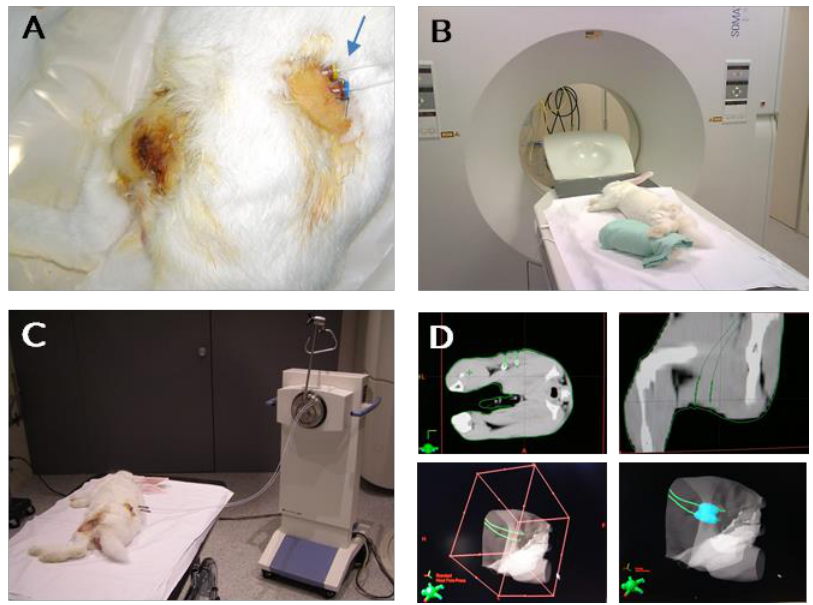
Figure 1. Images of rabbits undergoing brachytherapy procedure. ( A ) Catheters implantation in left posterior rabbit ’ s limb as brachytherapy source applicator (blue arrow). ( B ) Imaging assurance of correct positioning of catheters through SOMATOM CT Sliding Ganty ( C ) Air pressure control of radioactive seeds delivery and positioning with a GammaMedplus IX (Varian Medical Systems). ( D ) 2D and 3D imaging guided axial visualization for virtual delivery of radioactive sources (BrachyVision™).